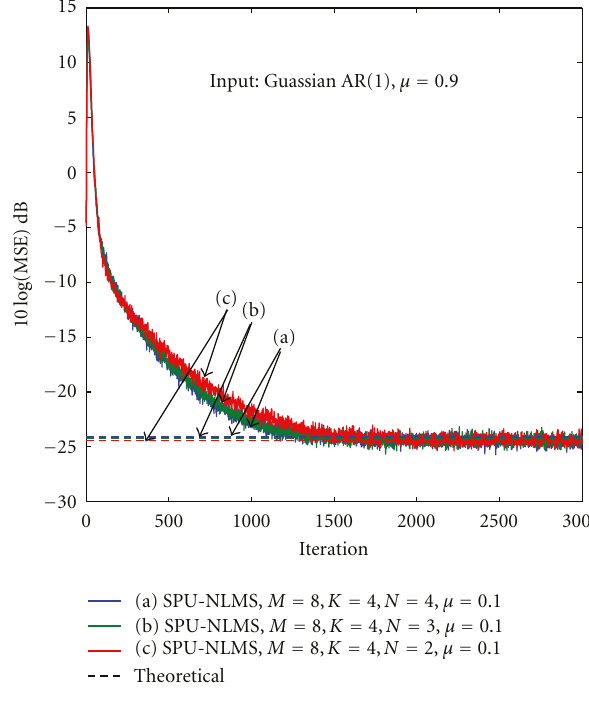
Figure 13: Learning curves of SPU-NLMS with M = 8, K = 4, and N = 2,3,4 for colored Gaussian input signal.